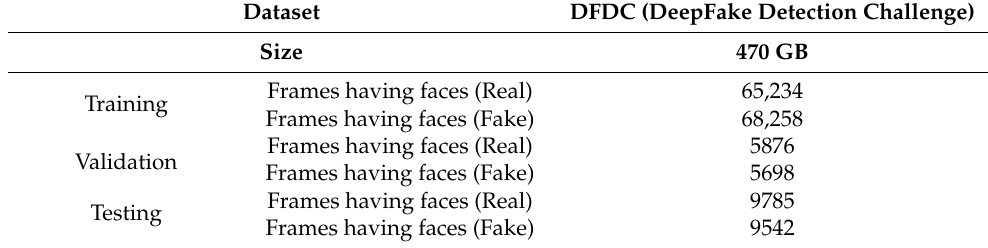
Table 3. Dataset Table 3. Dataset statistics.